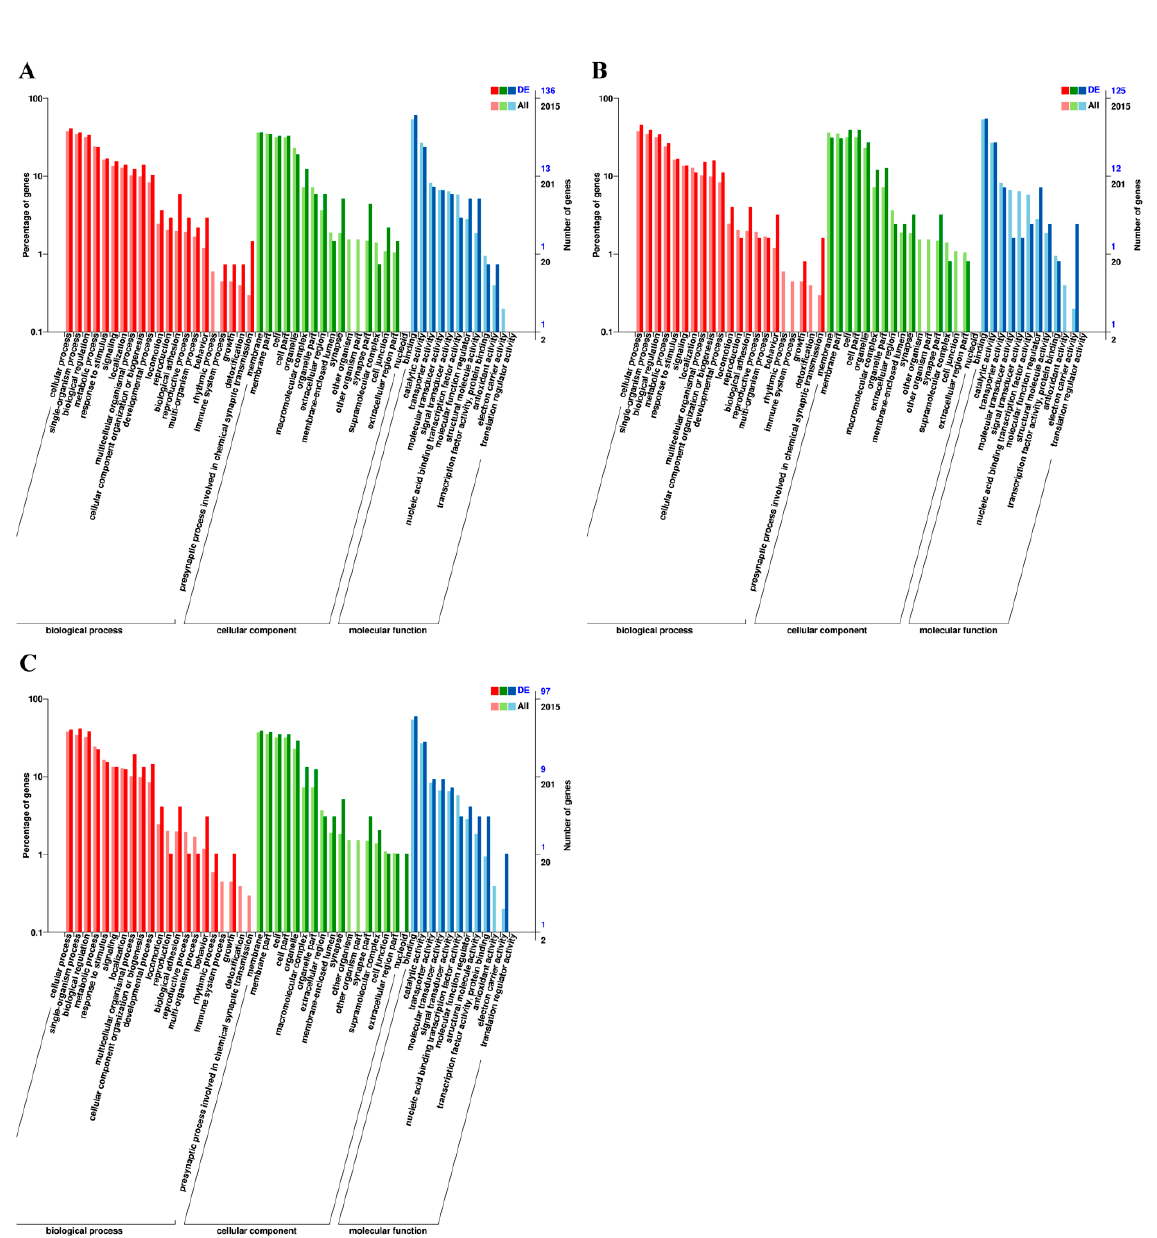
Figure 5. Gene ontology (GO) term enrichment analysis of target genes in ( A ) R5d vs. E5d; ( B ) R6d vs. E6d; and ( C ) R7d vs. E7d.